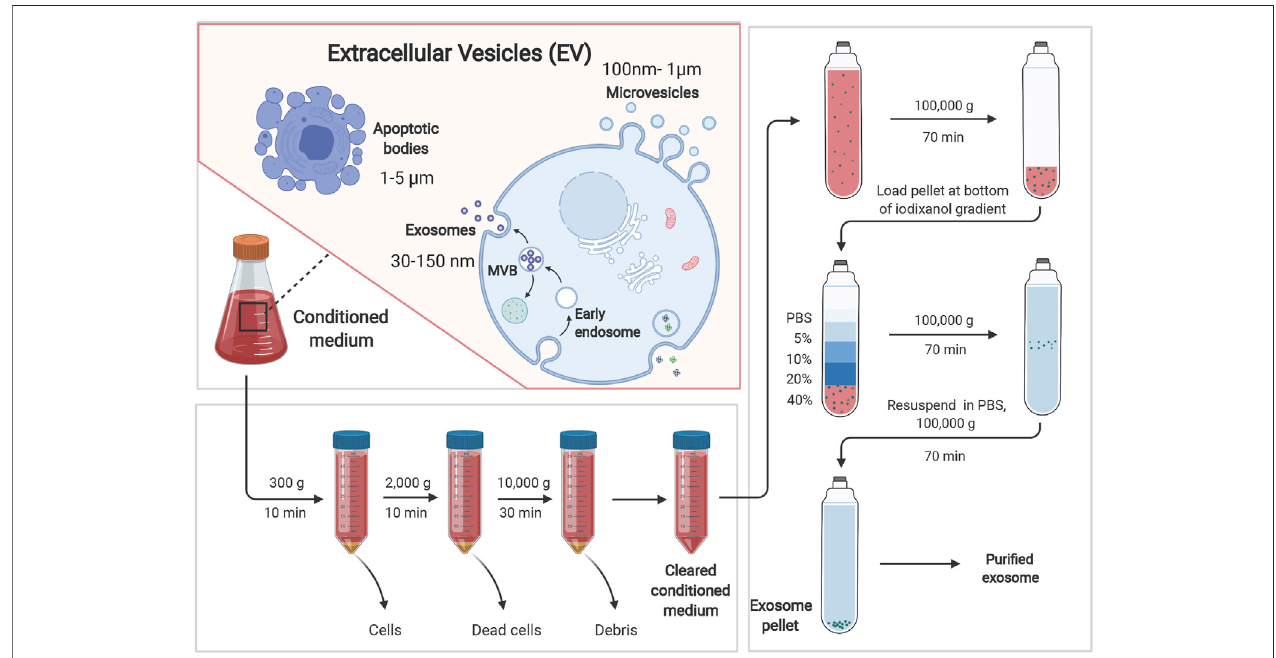
FIGURE 2 | Exosomes can be separated by ultracentrifugation-based isolation techniques. Extracellular vesicles (EVs) can be divided into three main categories: microvesicles, exosomes and apoptotic bodies. Ultracentrifugation-based isolation techniques are the most used for the isolation of exosomes. Brifely, the culture supernatant was centrifuged at 300 × gfor 10 min at 4 ° C, at 2,000 × g for 10 min, and at 10,000 × gfor 30 min. Aftercentrifugation, the supernatant wascollected. The supernatant was ultra-centrifuged at 100,000 × g for 70 min to pellet the exosomes. Exosomes were washed with PBS and pelleted by ultracentrifugation for 70 min at 100,000 × g.